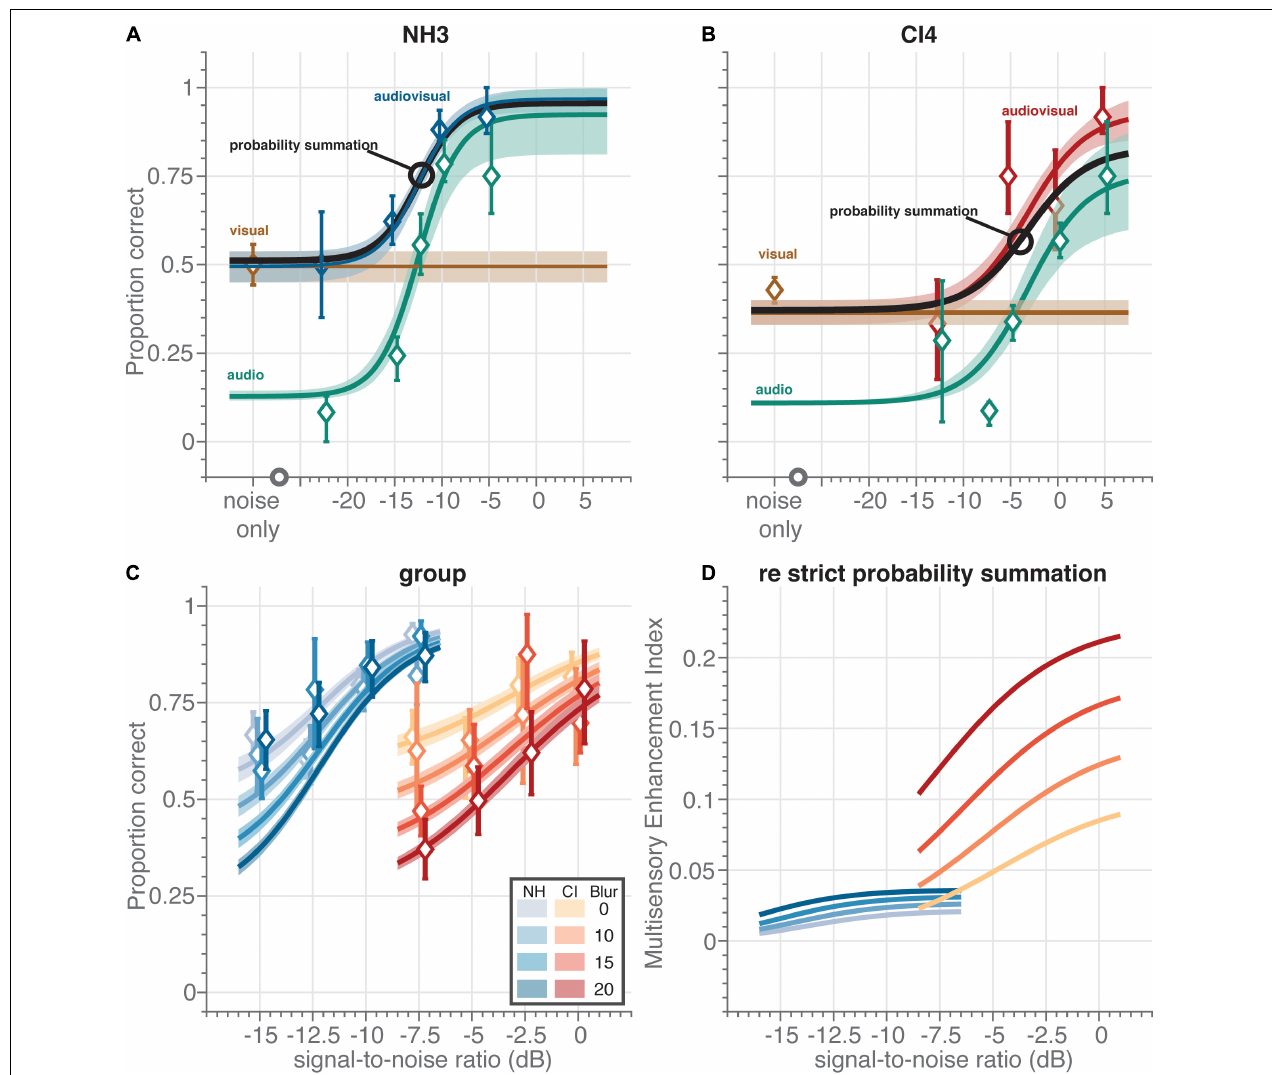
FIGURE 3 | Multisensory speech recognition. Individual data and fit for (A) normal-hearing (NH) participant NH3 and (B) CI user CI4. All data was obtained from the divided-attention task. For the visual and audiovisual sentences, the video blur was 10 pixels. Symbols and bars indicate mean and 95%-confidence intervals, respectively, of the raw data (proportion correct) pooled across participants. The data was obtained (by definition) from the divided-attention task. Curves and patches indicate means and 95%-HDI, respectively, of the psychophysical-function population fits. For comparative purposes, we show the fitted speech reading performance level as a horizontal brown line. (C) Audiovisual speech recognition scores as a function of acoustic signal-to-noise ratio (dB) for normal-hearing participants (blueish diamonds) and CI users (reddish diamonds) for four blur values (as indicated by contrast). (D) Multisensory enhancement index (MEI) as a function of acoustic signal-to-noise ratio (dB) for normal-hearing participants (blue colors) and CI users (red colors) for four blur values (as indicated by contrast). The MEI quantifies the multisensory enhancement of the trade-off model over strict probability